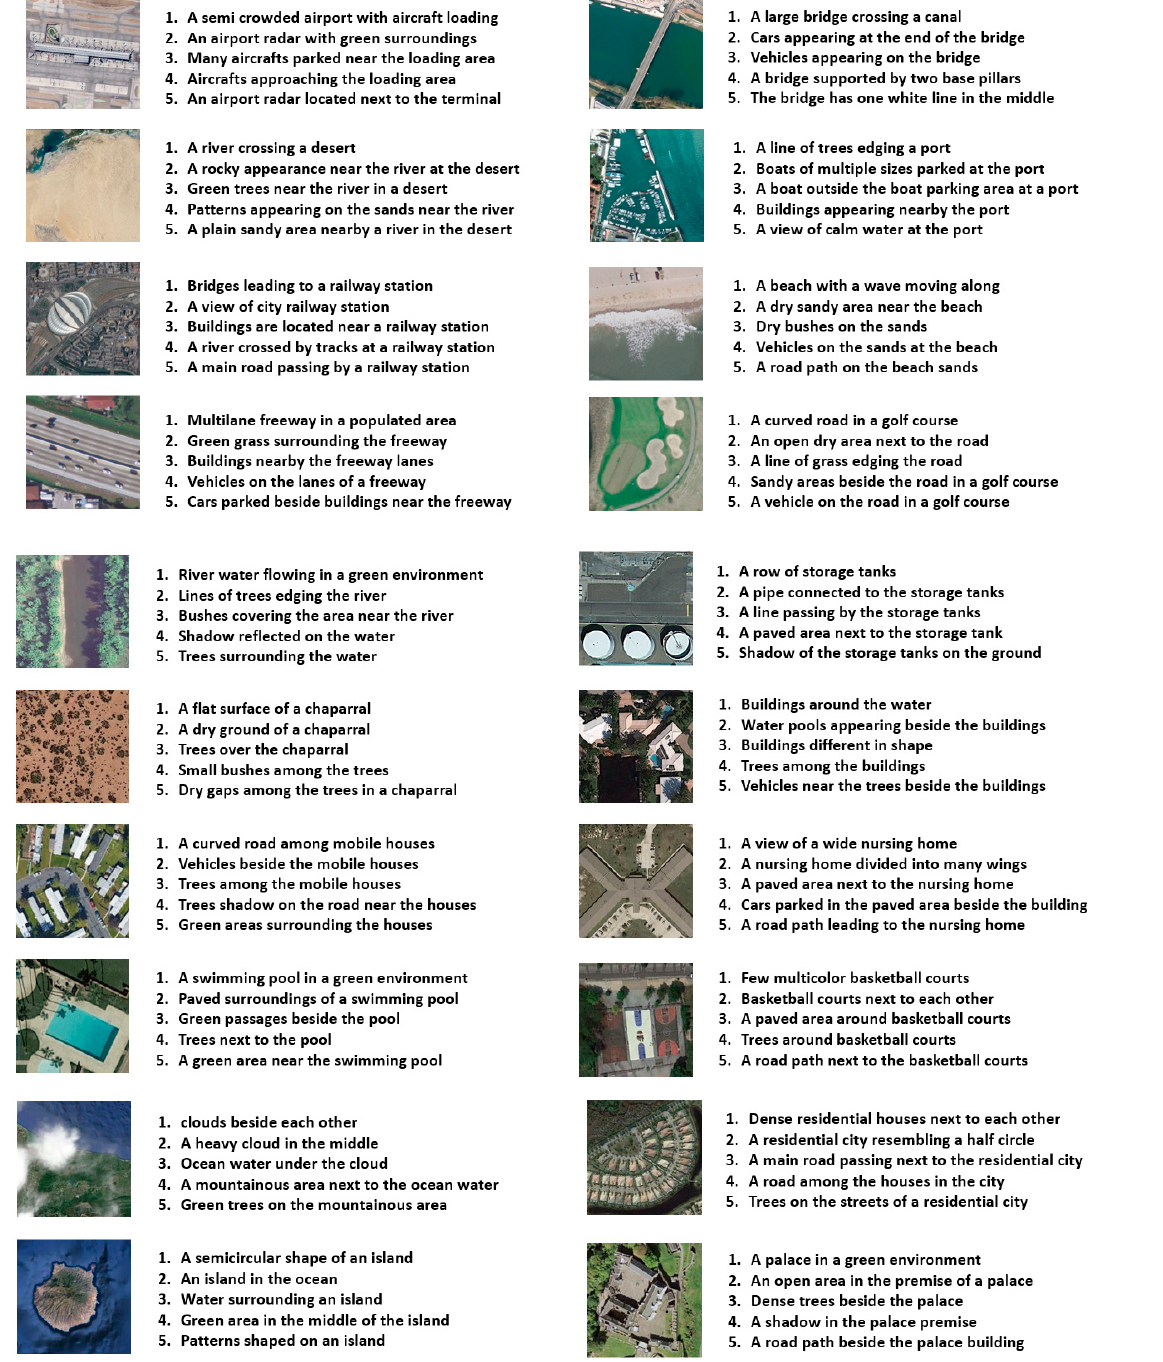
Figure 6. Example of images with the five sentences for each image.